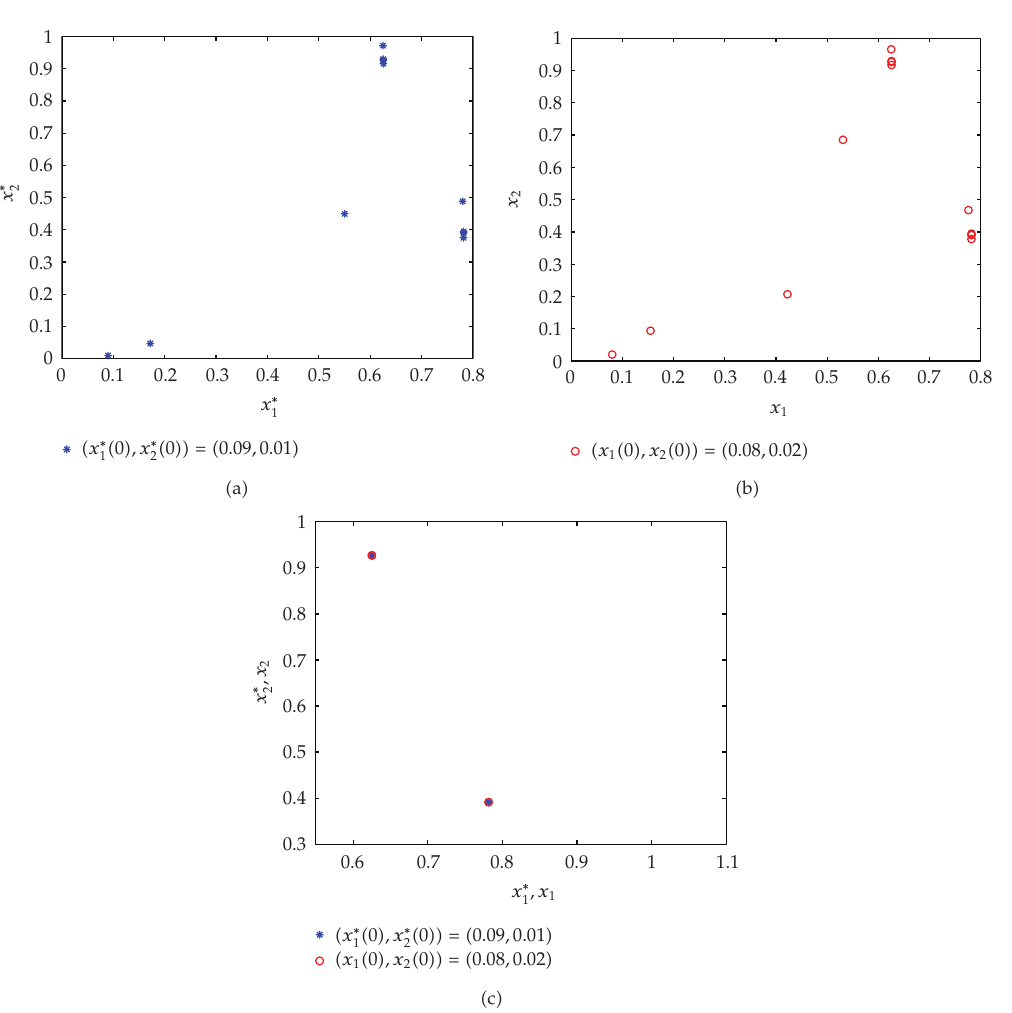
and x ∗ with initial value (cid:6) 0 . 09 , 0 . 01 (cid:7) for n ∈ (cid:2) 0 , 50 (cid:3) . (cid:6) b (cid:7) Phase portrait of x 1 2 1